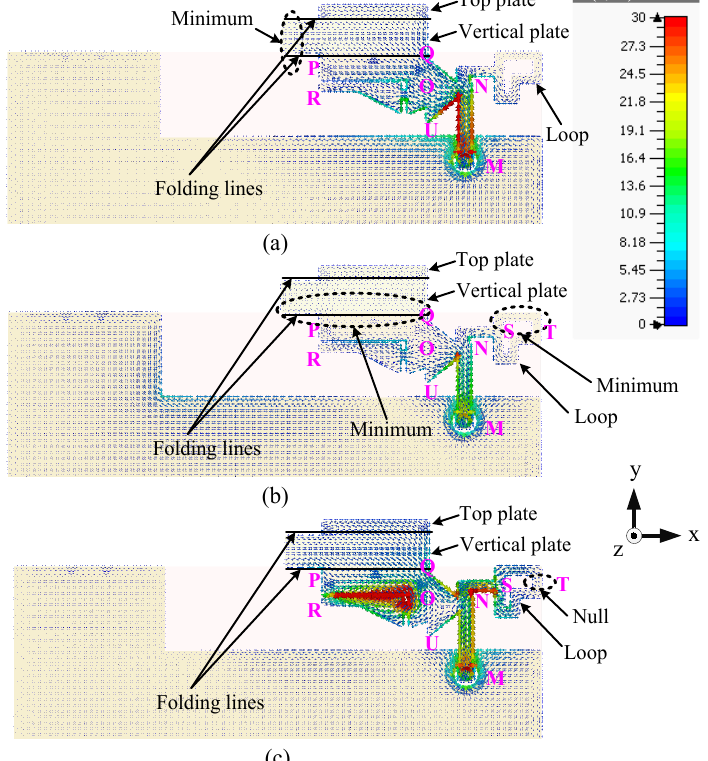
Figure 15. Surface current distributions of the wideband antenna (Ant#3) at ( a ) 1.8, ( b ) 2.6, and ( c ) 3.6 GHz.